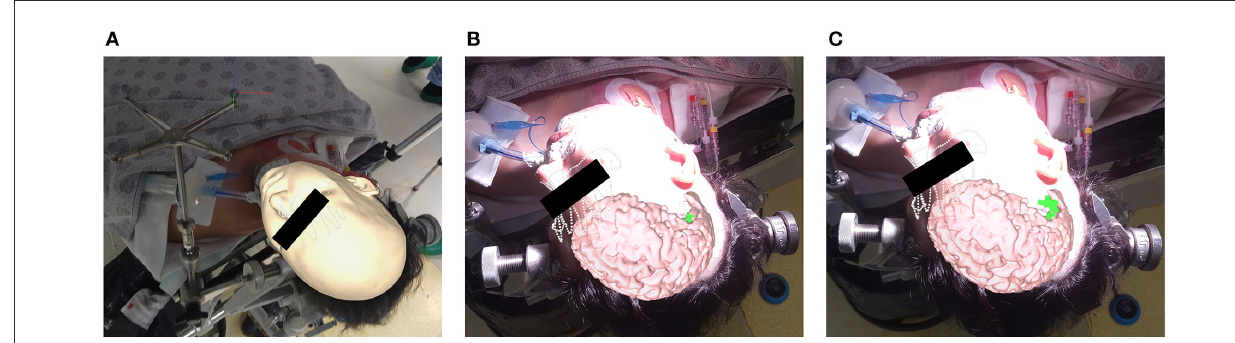
FIGURE6 Example of the sequence that the investigators followed within the AR application. (A) Patient installed in the Mayfield clamp, with the Brainlab reference star rigidly attached. The RGB axes visible on the Brainlab reference star indicate the established 3D cartesian coordinate system in which the patient’s position is being tracked. The virtual skin model is matched to the patient’s anatomy during the registration step, in which the boney surfaces along the patient’s face are digitized with the handheld stylus, resulting in a point cloud (white dots). (B) After registration, the virtual patient anatomy is displayed in its actual location. Here the cerebrum is shown in pink, with a deep-seated tumor recurrence (located in a previous resection cavity) shown in green. (C) An orthographic projection of the tumor is shown on the patient’s skin, allowing delineation of the tumor contours.